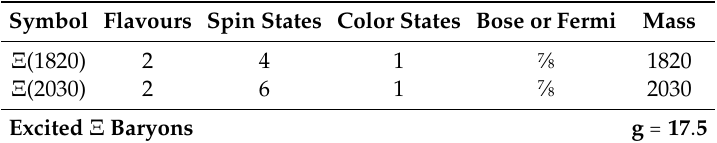
Table D7. Excited Ξ